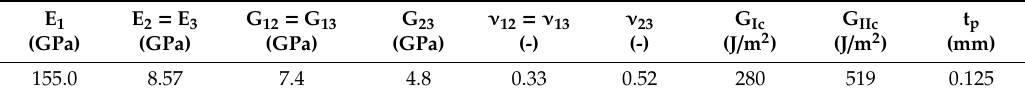
Table 3. T800 / 924 material